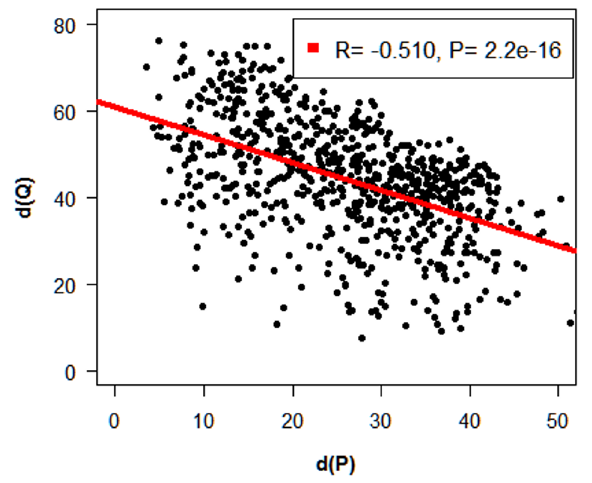
Figure 7. Relationship between the distances from the centromere to the nearest CO on the p [d(P)] (x-axis) and q [d(Q)] (y-axis) arms of chromosomes with at least one CO on each arm. The distances are expressed as percentages of the SC lengths. A significant negative correlation was found between the two distances, indicating that interference acts across the